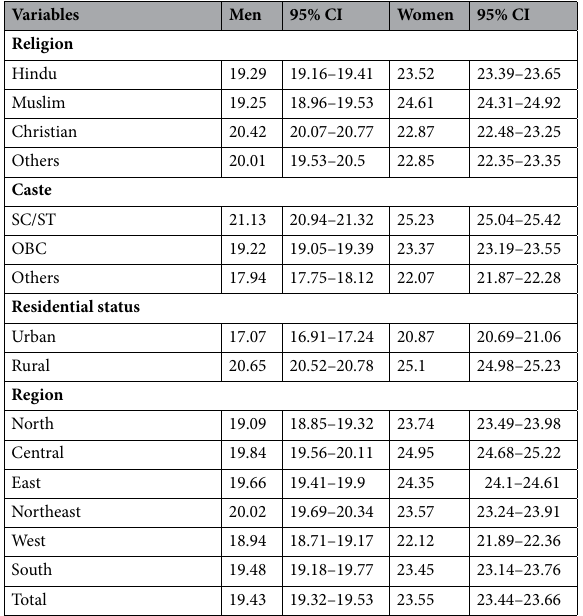
Table 2. Mean score of cognitive impairment (score ranges from 0 to 43) by background characteristics among older adults. CI Confidence interval, ADL Activities of daily living, IADL Instrumental activities of